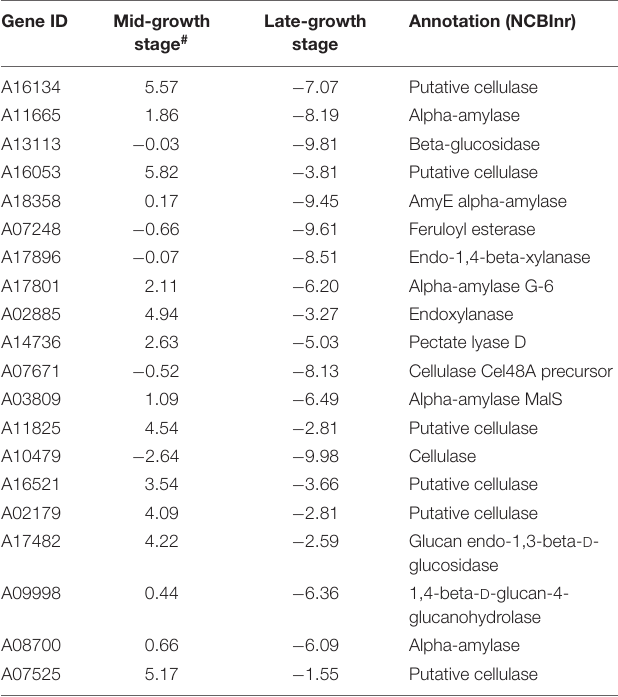
TABLE 5 | Top 20 differentially expressed fiber degrading enzymes at mid- and late-growth stages. Gene ID Mid-growth stage